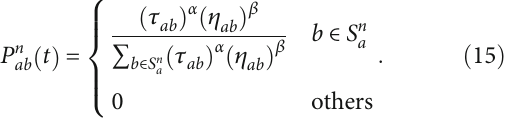
Figure 2: Linear decline.